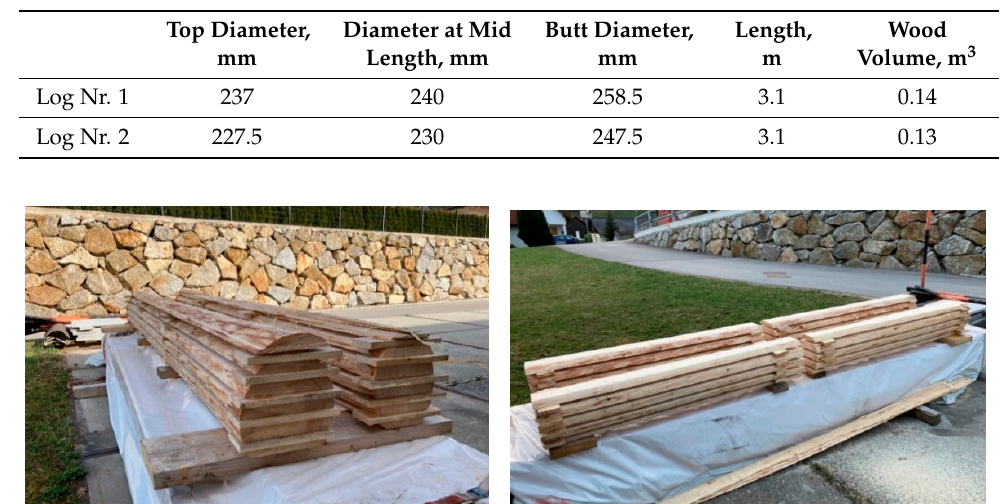
Table 2. Log dimensions (without bark).